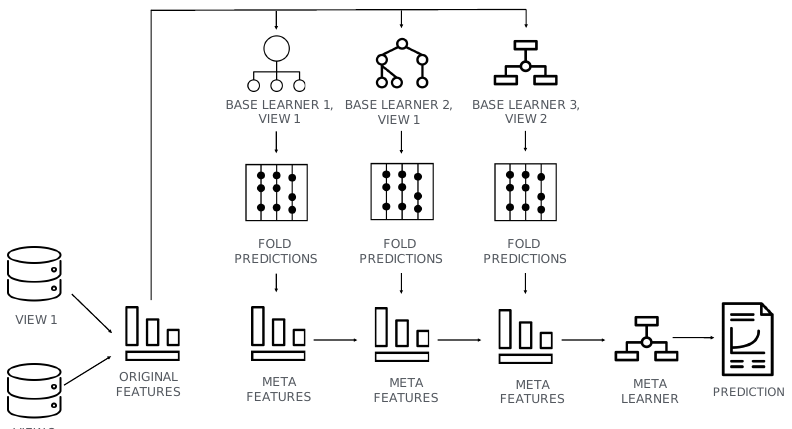
Figure 1. Multi-view stacked generalization framework’s illustrative example. Methodologically this computational framework’s example consists of three base machine learning models and a meta learner. The predictions of the base learners on validation folds are stacked together as meta features and presented for training to the meta learner model which outputs the final prediction. The illustrative example pipeline was trained on two subsets of features that allowed multi-view setting by training base learners 1 and 2 on features of view 1 and the base learner 3 on features of view 2. For the sake of simplicity, the example using only two views and three base learners is explained. In principle, number of views and base learners is not